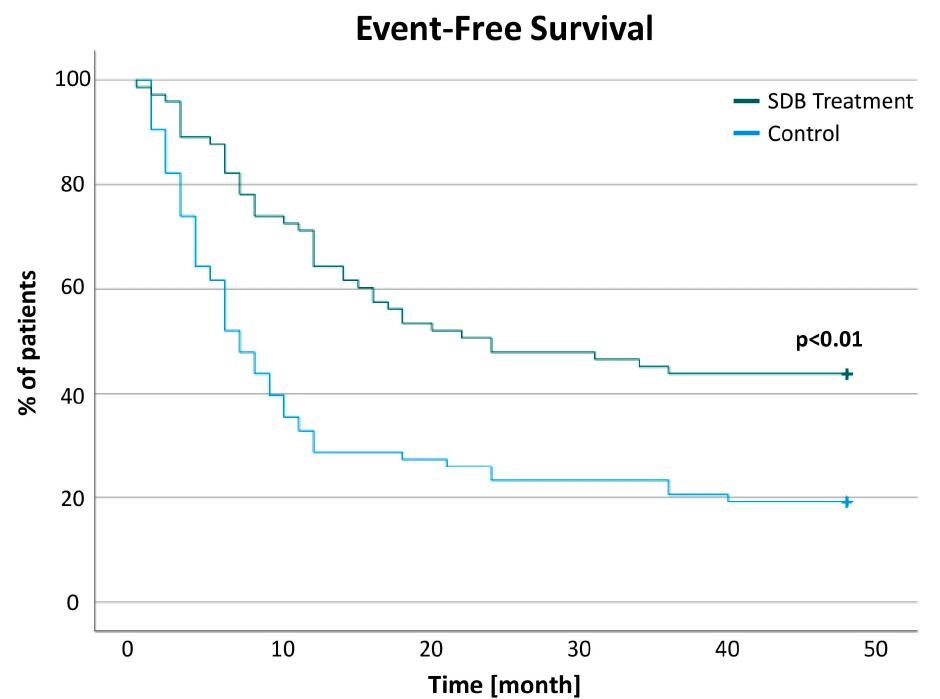
Figure 4. Heart failure patients with ICD and SDB who received SDB treatment showed a significantly longer event-free survival than patients with untreated SDB.